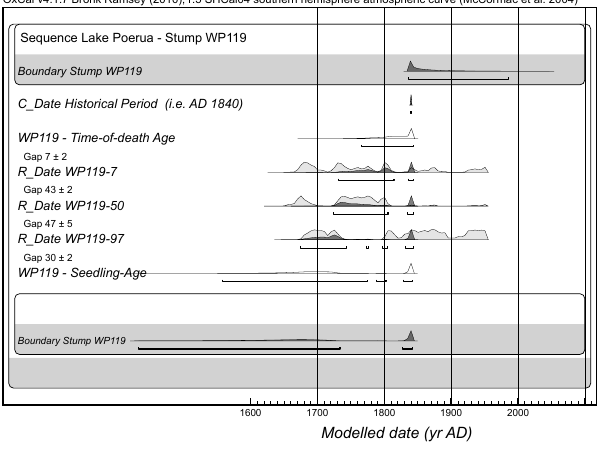
Fig. 9. OxCal plot of calibrated radiocarbon age distributions from tree stump WP119 in Lake Poerua. Dates are stacked from youngest to oldest (at bottom). The light grey probability density functions (PDFs) are prior distributions, while the dark PDFs are posterior or “shaved” distributions using the counted tree ring gaps. The distri- butions for the time-of-death age and the seedling-age are shown in